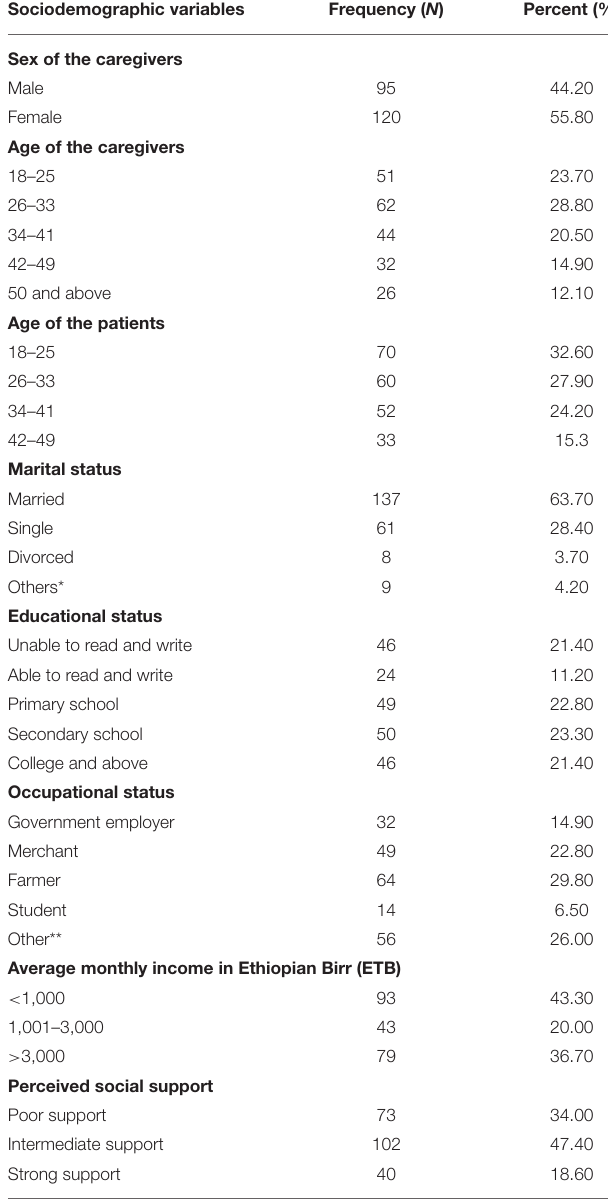
TABLE 1 | Sociodemographic characteristics of the primary informal caregivers of adults with mental illness at Hiwot Fana Specialized University Hospital (HFSUH) ( n = 215), Ethiopia,